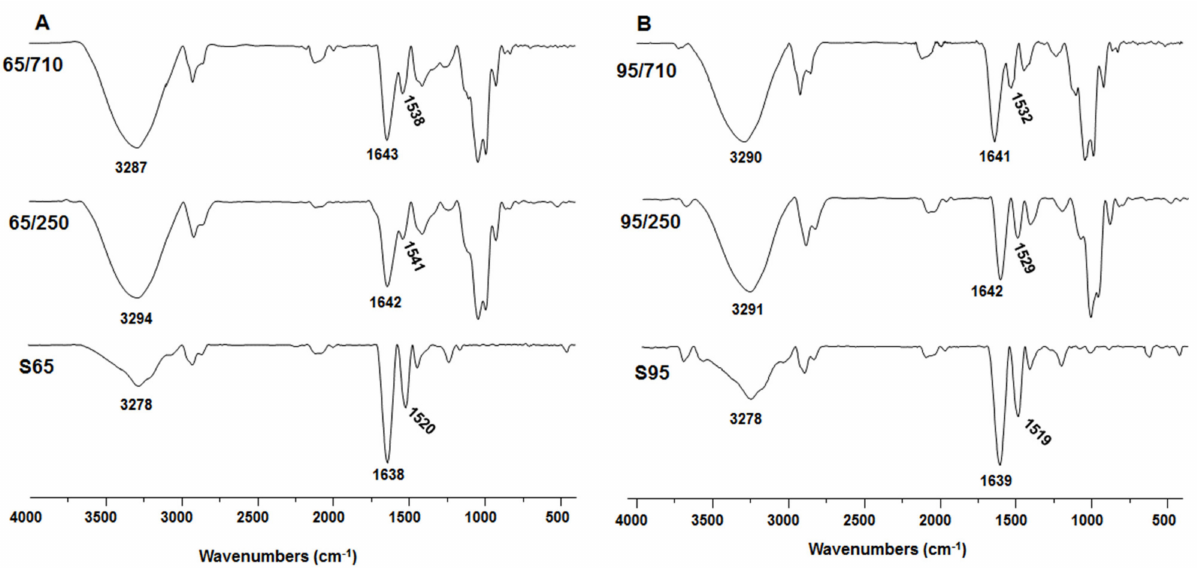
Figure 6. FTIR-ATR spectra of zein extracts by using ultrasonic homogenizer with ( A ) 65% ethanol aqueous and ( B ) 95% ethanol aqueous solution. S65: commercial zein in 65% ethanol; 65/250: extracted zein with 65% ethanol and 250 µ m flour granulation; 65/710: extracted zein with 65% ethanol and 710 µ m flour granulation; S95: commercial zein in 95% ethanol; 95/250: extracted zein with 95% ethanol and 250 µ m flour granulation; 95/710: extracted zein with 95% ethanol and 710 µ m flour